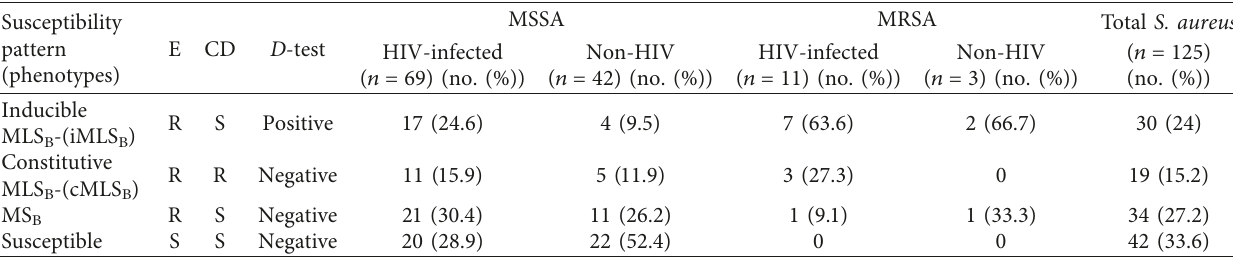
Table 4: Clindamycin resistance among MRSA and MSSA strains.